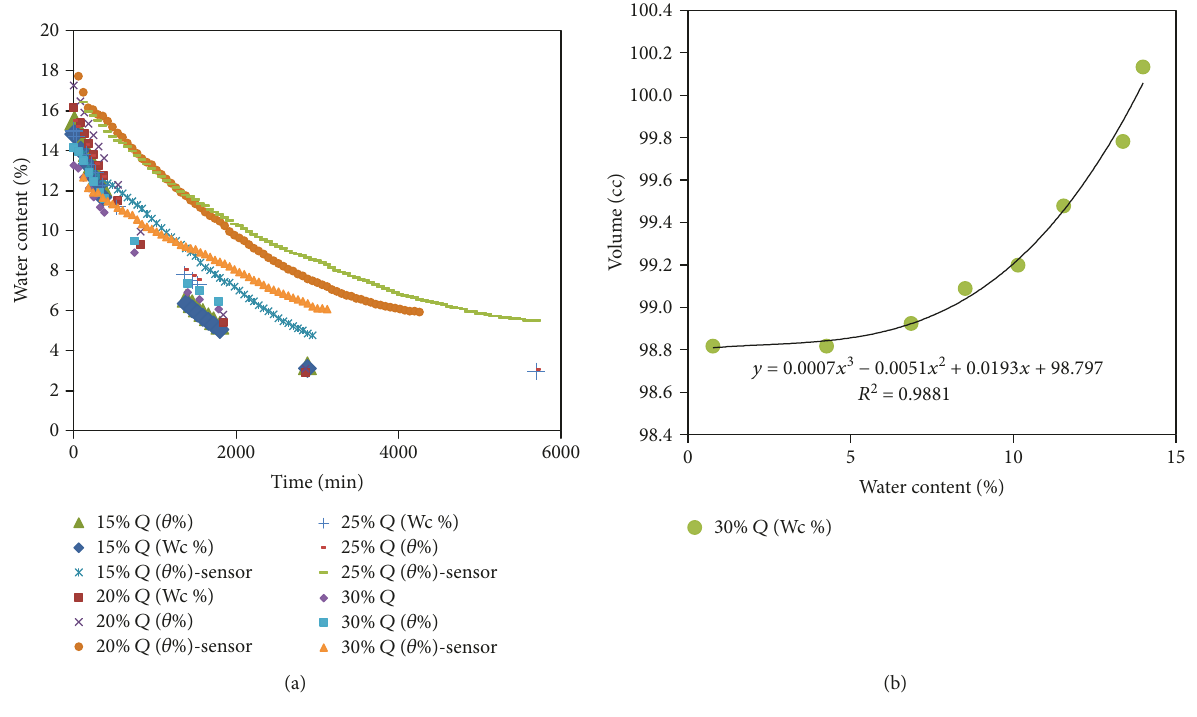
Figure 2: (a) Moisture as measured using three di ff erent methods for a range of clay content. (b) Volume changes for 30% clay mixture at variable moisture